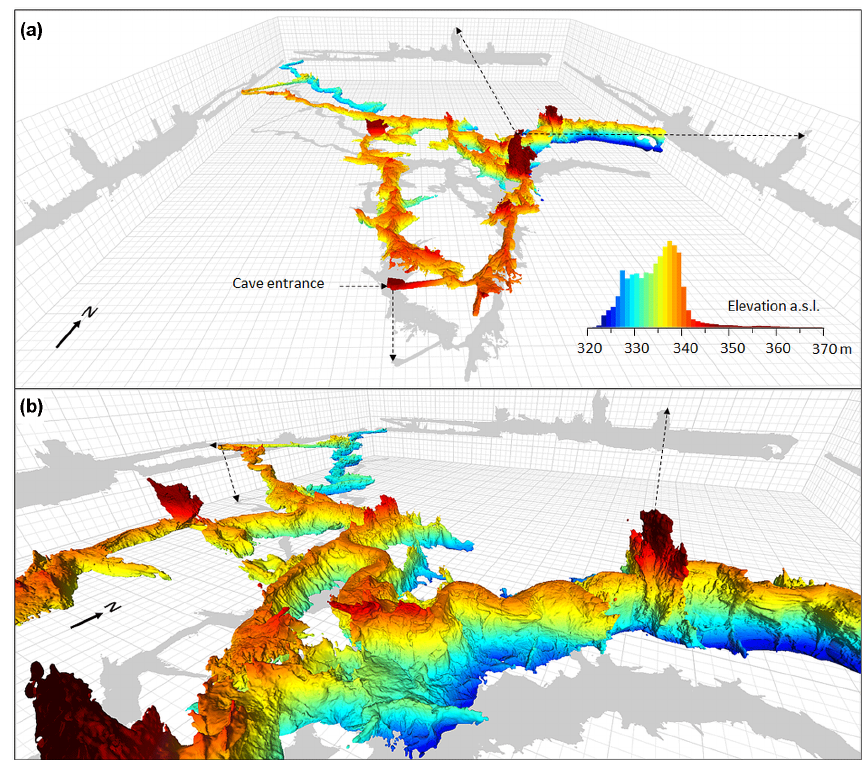
Figure 5. 3-D model of the Domica cave oriented towards the north (a) and its detailed view towards north-west (b) showing a meandering ceiling channel. The model is coloured by the value of altitude above mean sea level which distribution is shown by the histogram. The 3-D geometry is orthogonally projected on the XY , YZ , and XZ planes. The size of the major and minor cells in the background grid is 20 and 5m along all three axes, respectively. Note the flat, horizontal ceiling levels projected on the vertical XZ and YZ planes. Table 4. Summary statistics of the DEM data sets parameterizing morphology the scanned part of the Domica